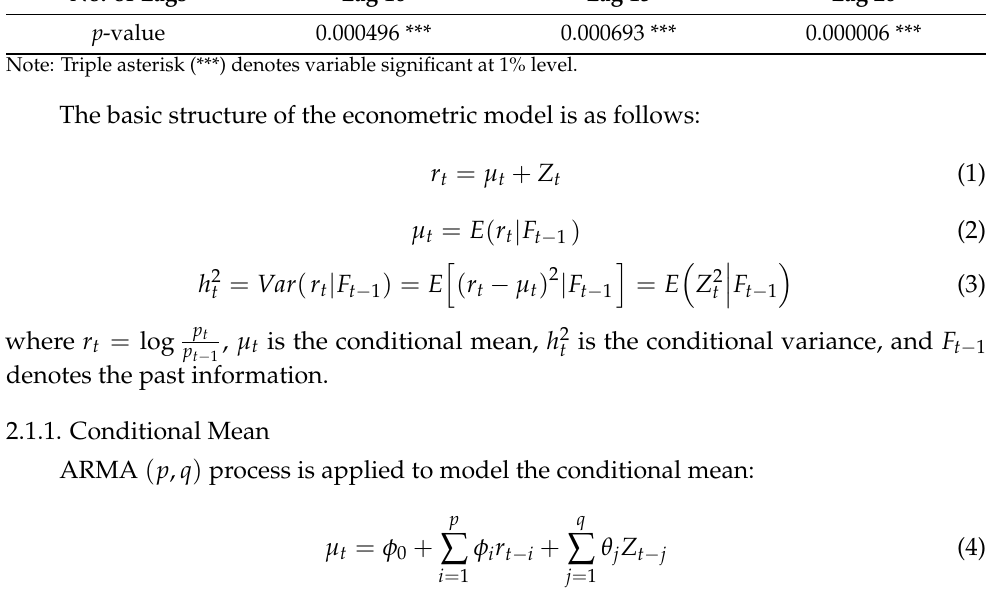
Table 3. Ljung-Box Q-Test for Bitcoin Daily Return. No. of Lags Lag 10 Lag 15 Lag 20 p -value 0.000496 *** 0.000693 *** 0.000006